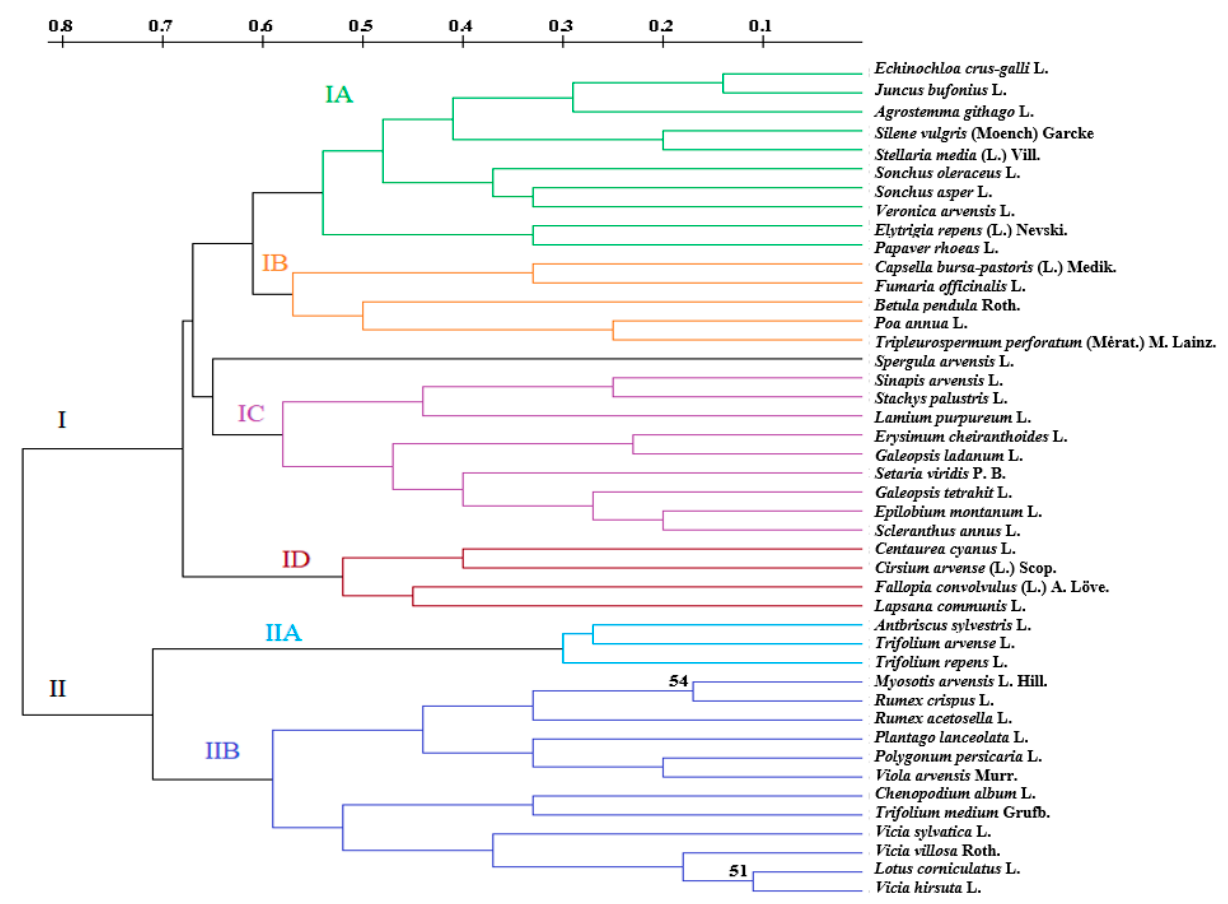
Figure 3. Hierarchical cluster analysis of soil seed bank using 27 morphological traits of seed shapes and surfaces. Roman numerals indicate the main clusters and subclusters according to different features of seeds, such as the surface (I—rough, II—smooth, IA—matte, IB—wrinkled, ID—furrowed, IIA—slightly shiny, IIB—shiny) or shape (IC—egg-shaped). The scale above the dendrogram indicates the distance coefficient between soil seed banks using morphological traits of seeds. Arabic numerals above branches indicates the bootstrap values in percentages.